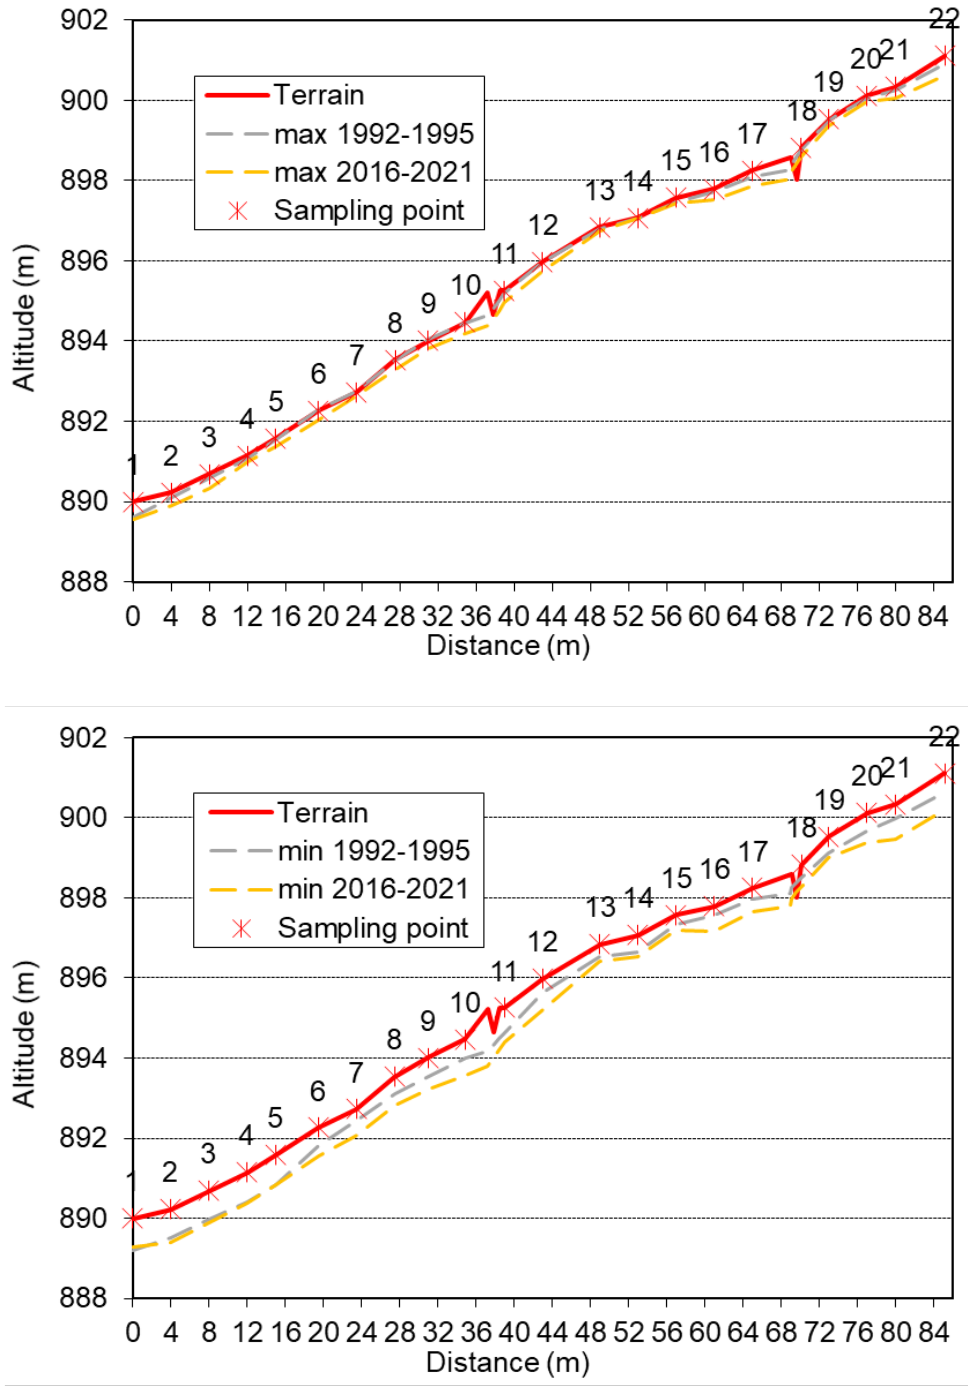
Figure 11. Slope of the experimental transect area and the average minimum ( above ) and maximum ( below ) GWTs during the vegetation periods of 1992–1995 (a mostly deforested, calibration period before the drainage system was constructed) and 2016–2021 (the last period, forest cover restored). The numbers represent the position of the measuring probes.